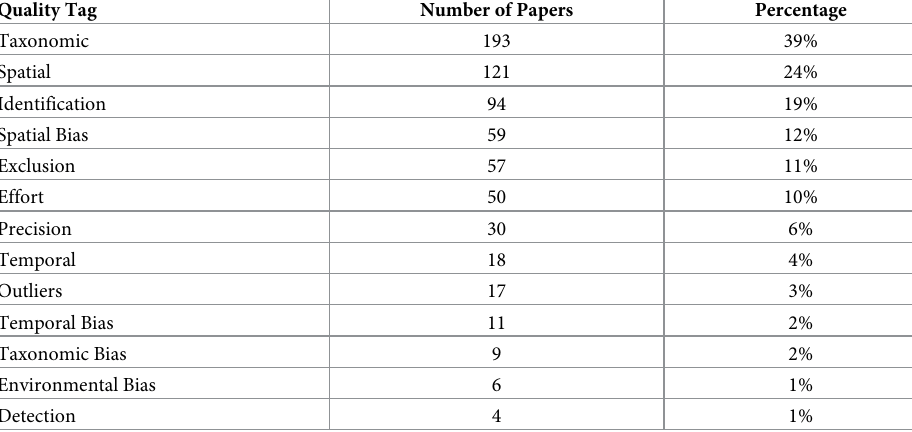
Table 6. Papers from dataset ( n = 501) that addressed data quality issues associated with species occurrence records. Quality